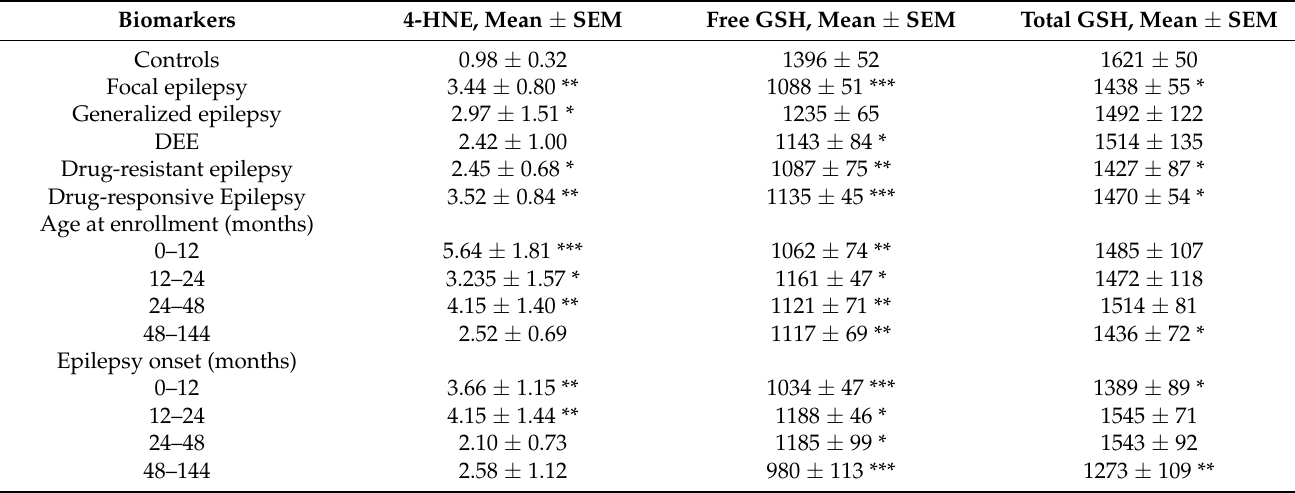
Figure 2. Ferroptosis biomarkers in sub-groups of children with epilepsy. The lipid peroxidation products, 4-HNE ( A ) and GSH ( B ), were determined in blood of children with focal epilepsy ( n = 52), generalized epilepsy ( n = 17), DEE ( n = 14). 4-HNE ( C ) and GSH ( D ) were detected in blood of drug-resistant epilepsy ( n = 29) and drug-responsive ( n = 54) children. Data are expressed as median ± SEM. Statistical significance is defined as * p < 0.05, ** p < 0.01, *** p < 0.001 with respect to controls. Table 3. Blood ferroptosis biomarkers in sub-groups of children with